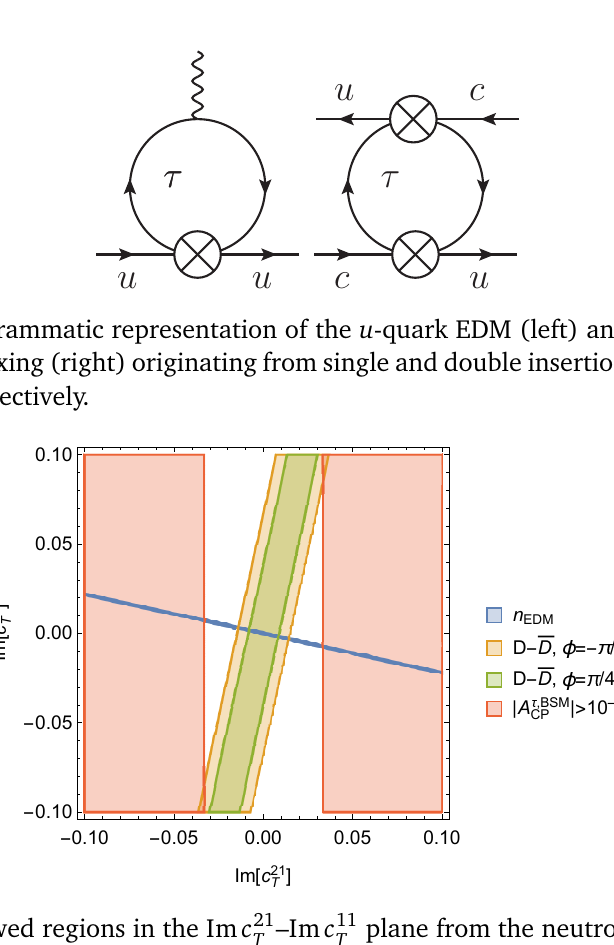
–Im c 11 plane from the neutron EDM and D – T T